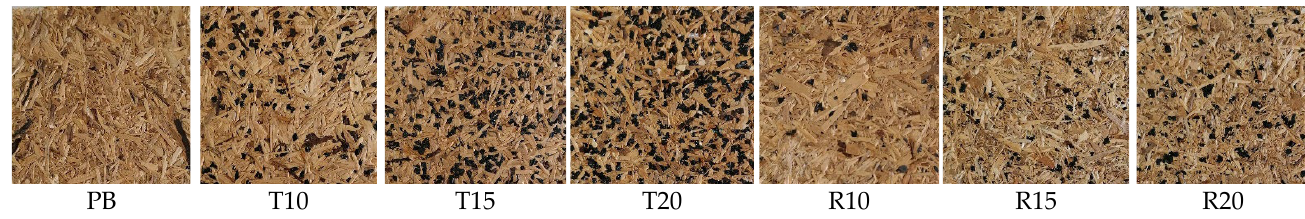
Figure 2. Samples of composites used for the determination of spontaneous ignition temperatures (20 × 20 × 15 mm, length × width × thickness). Table 1. Composite characterization.